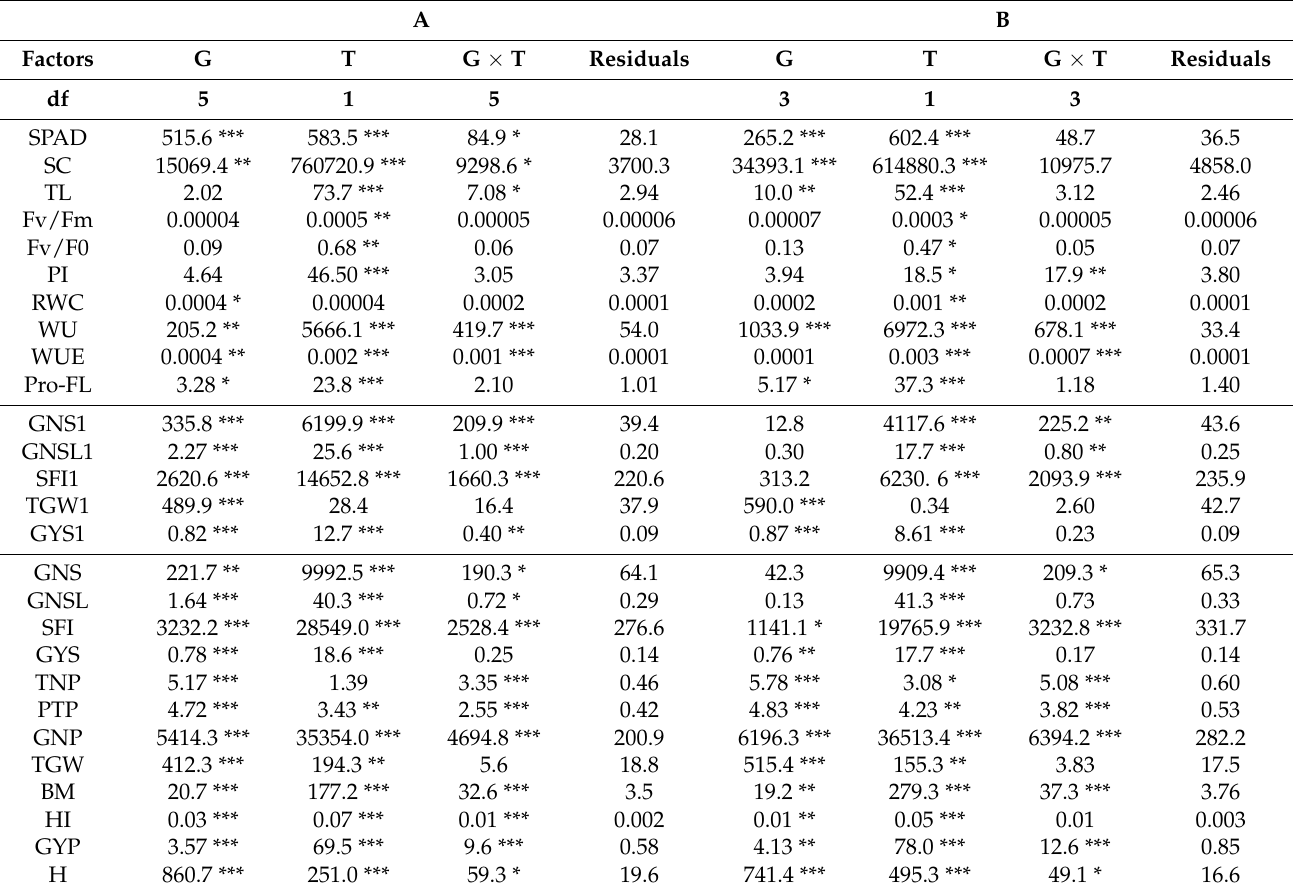
Table 4. ANOVA mean squares for physiological, biochemical and yield-related traits measured under control and combined water-deficit and 7-day HS stress (WH7): (A) comparison between alien segment carrier (+) and non-carrier ( − ) NIRLs, and (B) comparison between NIRLs+ and cv. Margherita. *, **, and *** indicate significance at p < 0.05, p < 0.01 and p < 0.001 levels, respectively. For trait acronyms, see the Materials and Methods